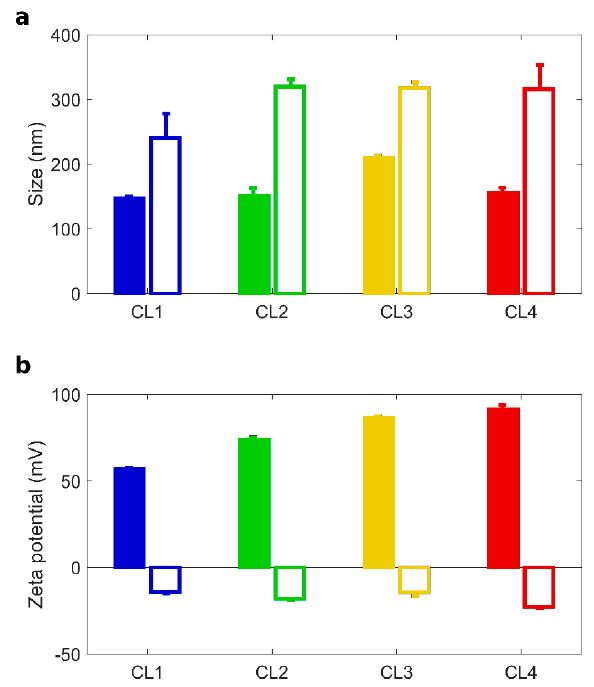
Figure 1. Size and zeta potential of TMZ-loaded CLs with and without BC. Size ( a ) and zeta-potential ( b ) of Temozolomide (TMZ)-loaded CLs (full histograms) and TMZ-loaded CL biomolecular corona complexes (empty histograms): CL1 (DOTAP/cholesterol), CL2 (DOTAP/DOPE), CL3 (DC Chol/DOPE), CL4 (DC-Chol/cholesterol).